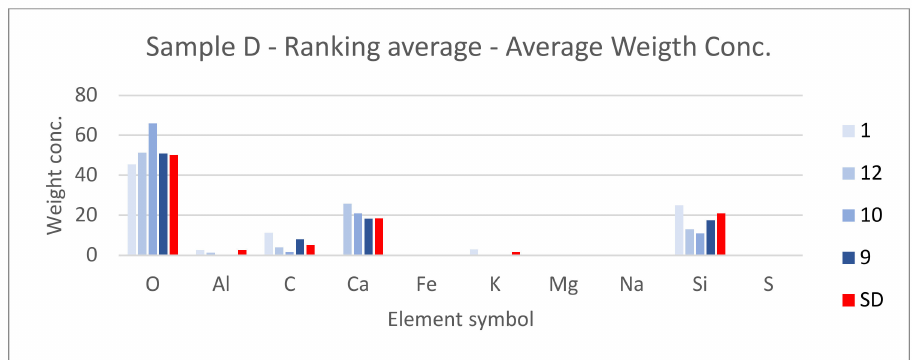
Figure 25. Sample D—ranking average—average weight concentration.